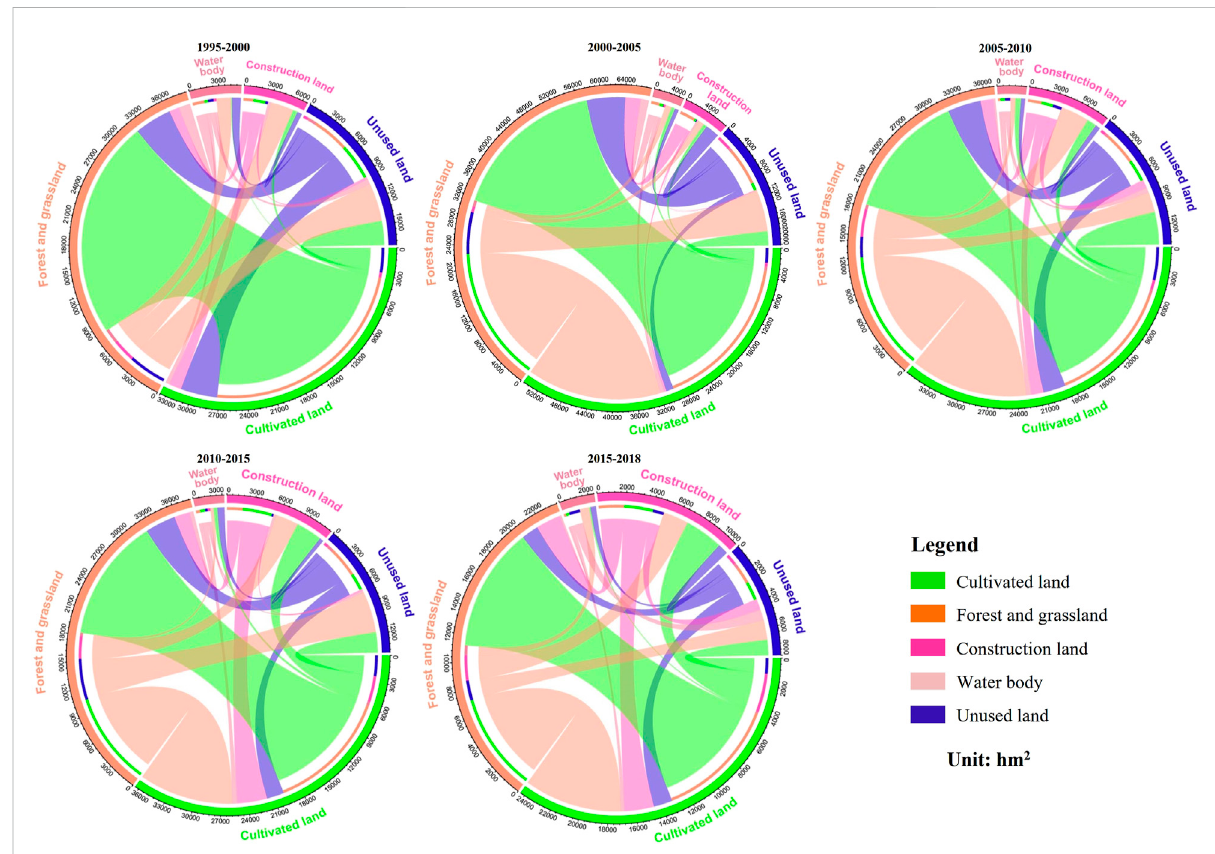
FIGURE 5 Land use types transfer in the basin area of Yuxi City from 1995 to